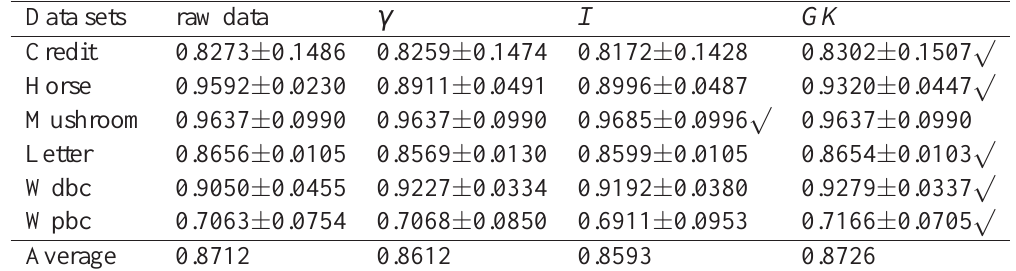
Table 8: Comparison of classification accuracies based on different methods with CART Data sets